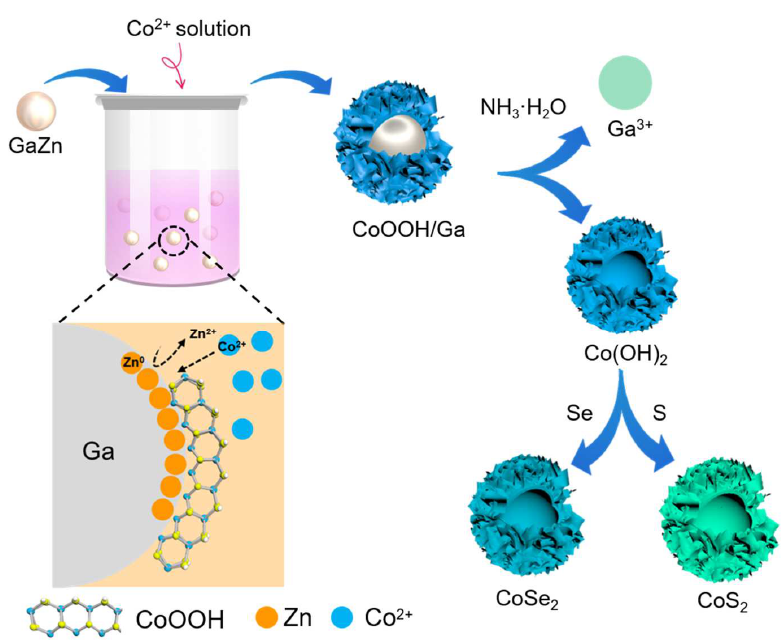
Figure 1. Schematic illustration of the formation for the Co-based compounds.